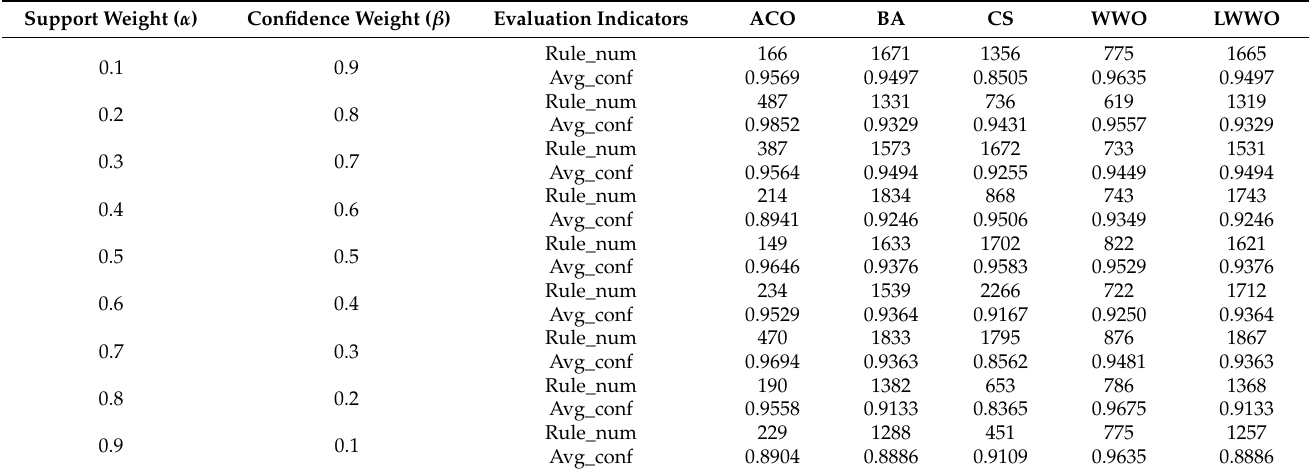
Table 3. Different weight of support and confidence